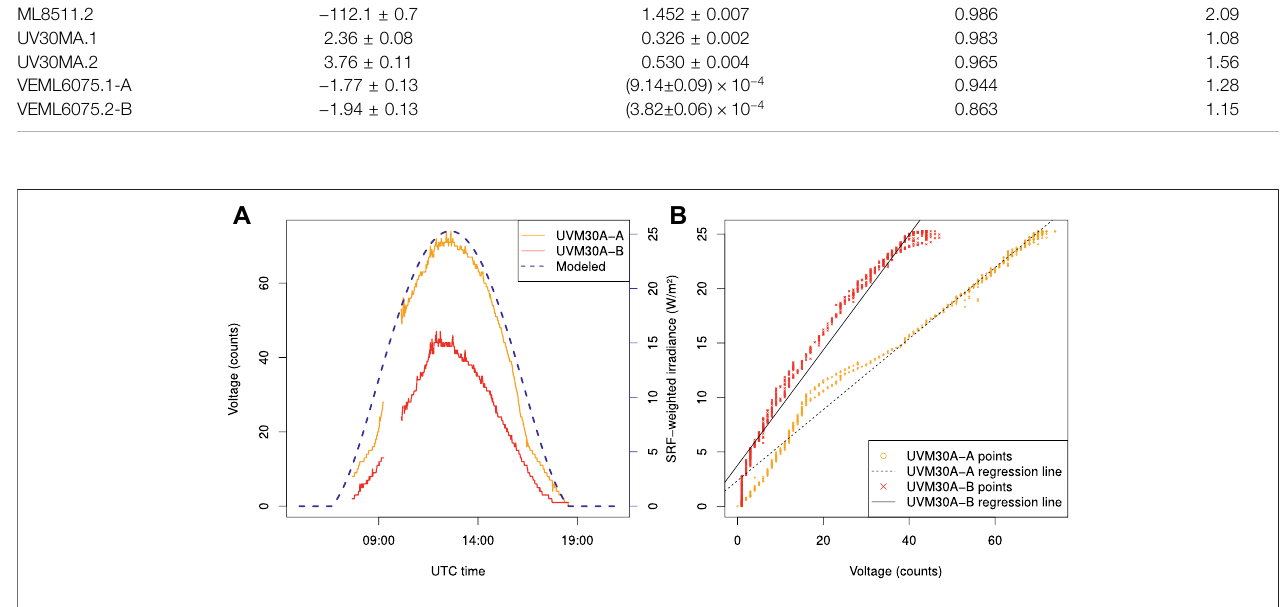
FIGURE 8 | Comparison of model estimations and UVM30A measurements: diurnal evolution (A) and regression (B) .